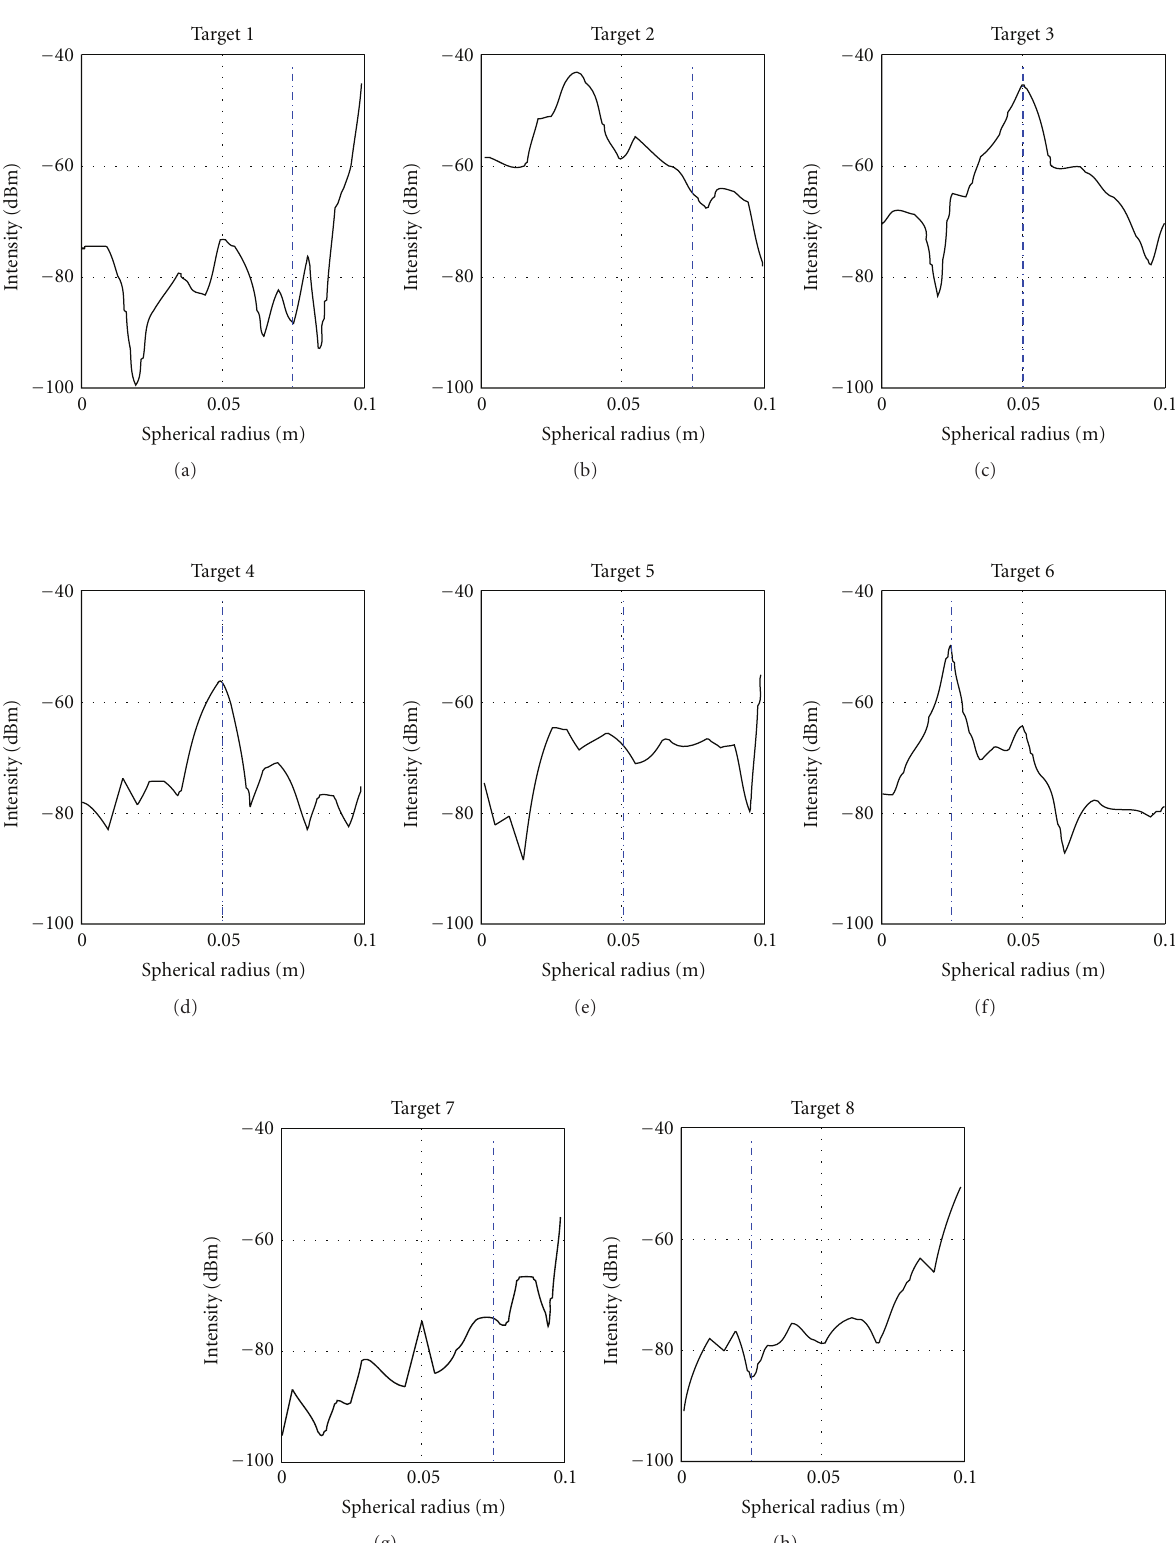
Figure 24: Variation in intensity versus spherical search radius for each target. The origin of each target was determined by peak intensity of each target cluster. Actual target radii are indicated by the dashed/dotted